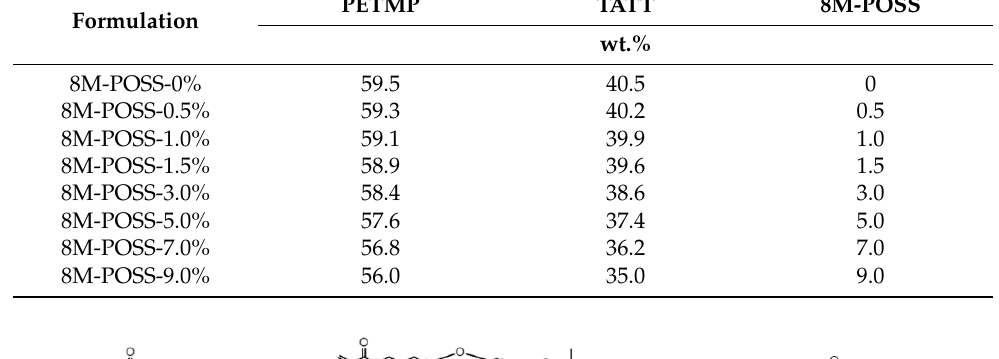
Table 1. Formulations of the thiol-ene matrix with 0.2 wt.% of DMPA photoinitiator. Formulation